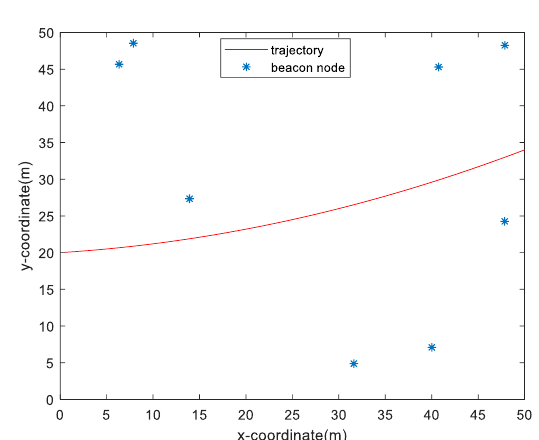
Figure 3. The trajectory of a mobile node .